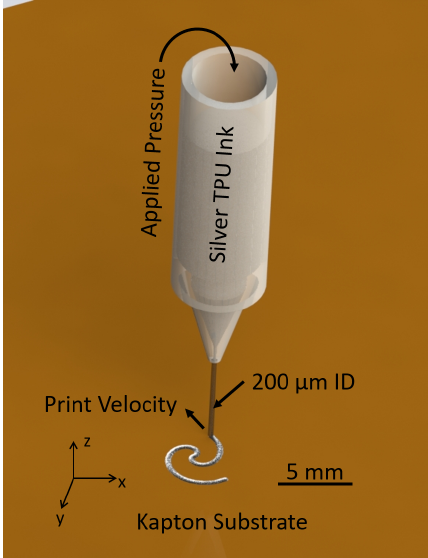
Figure A1. Print setup denoting syringe placement and size for extrusion direct-ink write